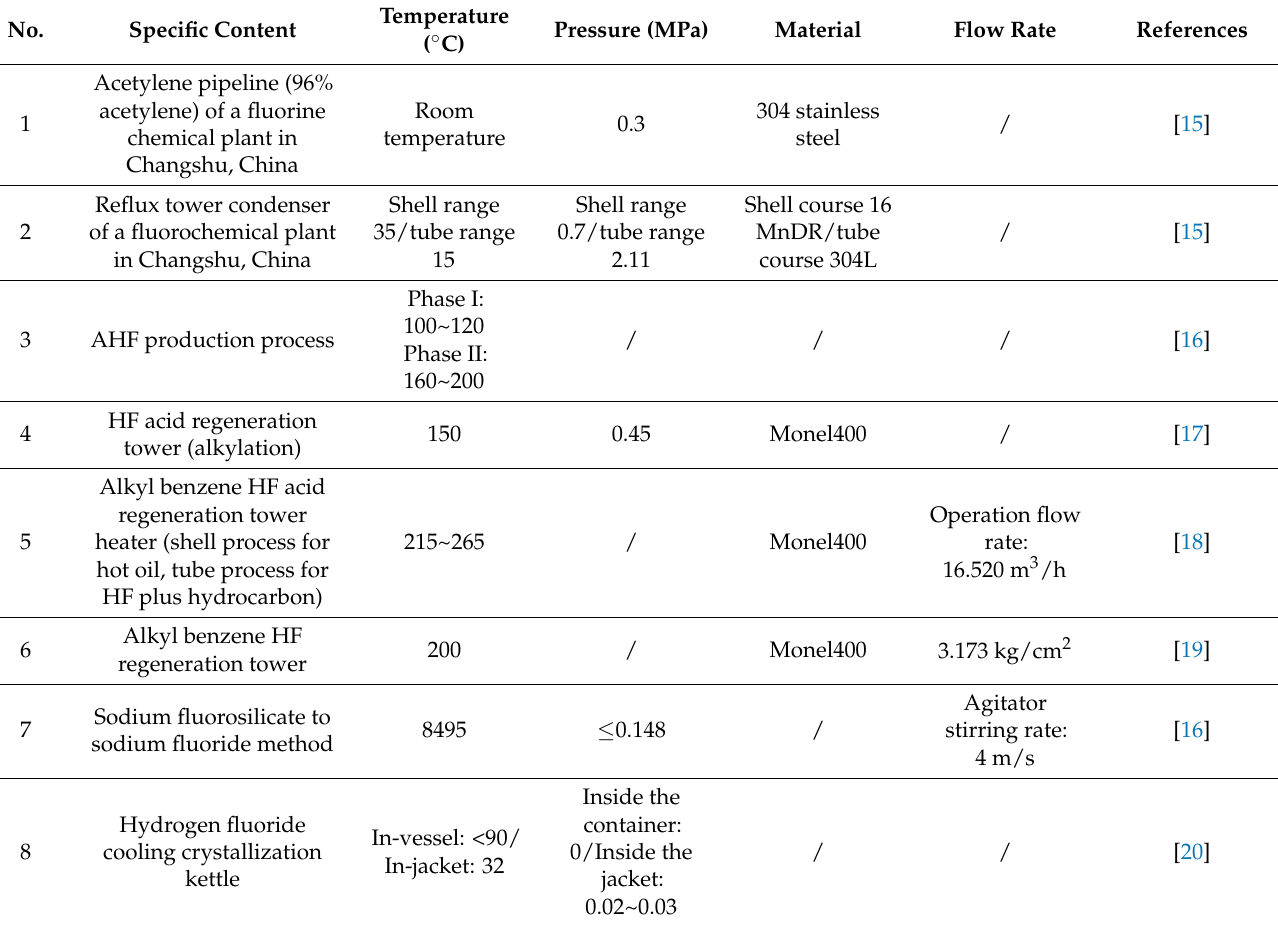
Table 1. Working conditions of fluorinated chemical